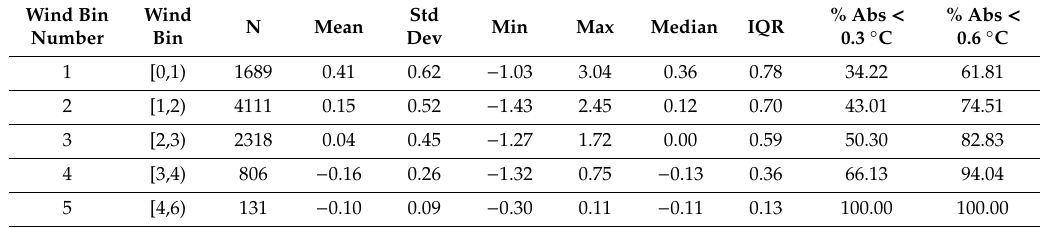
Table A2. Statistics of the Temperature Di ff erences ( ◦ C) between the twelve iMET-XQs and the 1.5 m tower sensor, in five wind speed bins used to assess the accuracy of the iMET-XQ sensors as a function of wind speed. IQR stands for Inter-Quartile